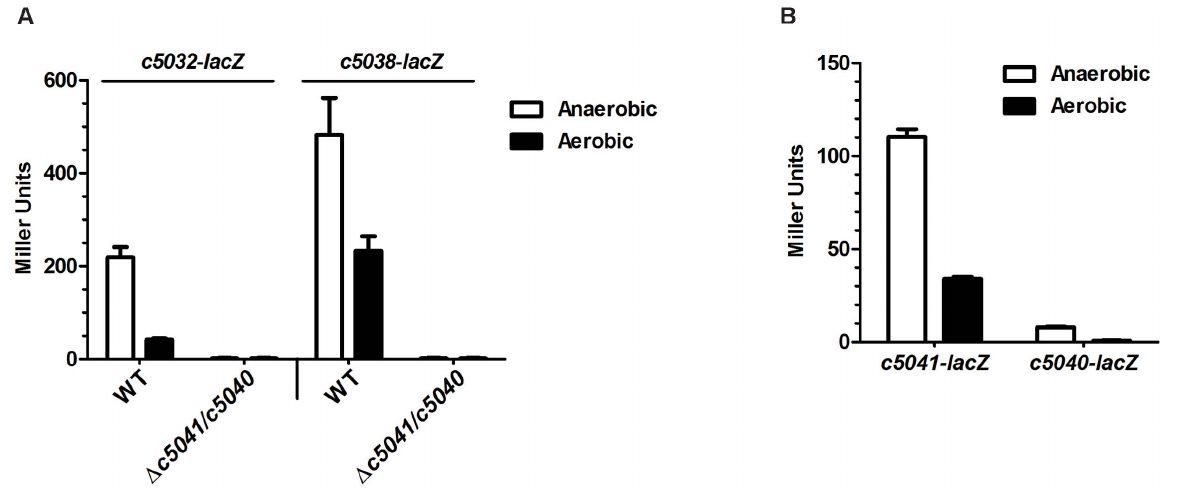
Figure 8. Oxygen tension modulates the expression of two operons in genomic island via TCS C5041/C5040. (A) Target genes’ expression in c5041 / c5040 mutants under aerobic and anaerobic conditions. The expression of c5032 - lacZ or c5038 - lacZ in WT and D c5041 / c5040 mutant (LMP108) under aerobic and anaerobic conditions were compared. (B) Induction of c5041 / c5040 expression by oxygen deficiency. c5041 - lacZ and c5040 - lacZ transcriptional fusion strains were grown in M9 medium containing a -KG as the sole carbon source under aerobic and anaerobic conditions, respectively. b -galactosidase activity was measured and the values shown are means plus standard deviations of triplicate samples.